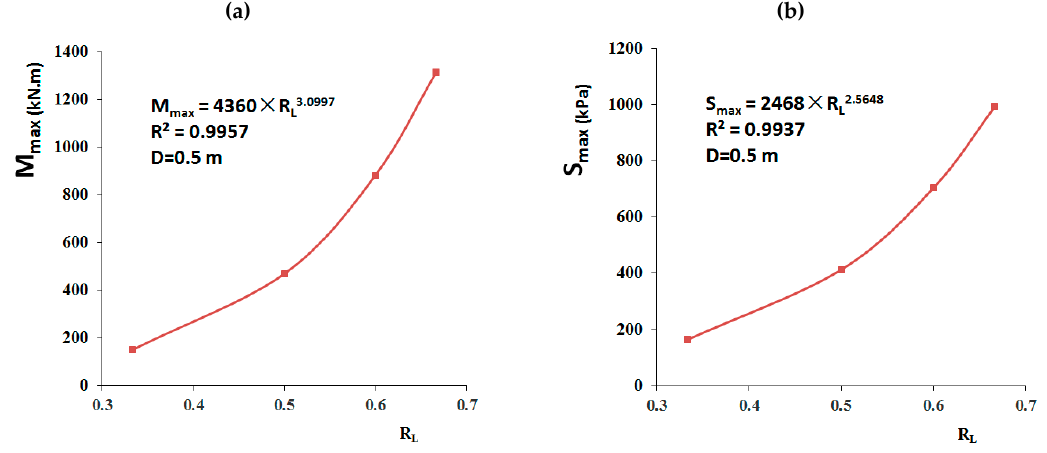
Figure 7. Relationship between the maximum internal force for varying buried depth and the sliding depth ratio: ( a ) relationship between the maximum bending moment and the sliding depth ratio; and ( b ) the relationship between the maximum soil reaction force and the sliding depth ratio.